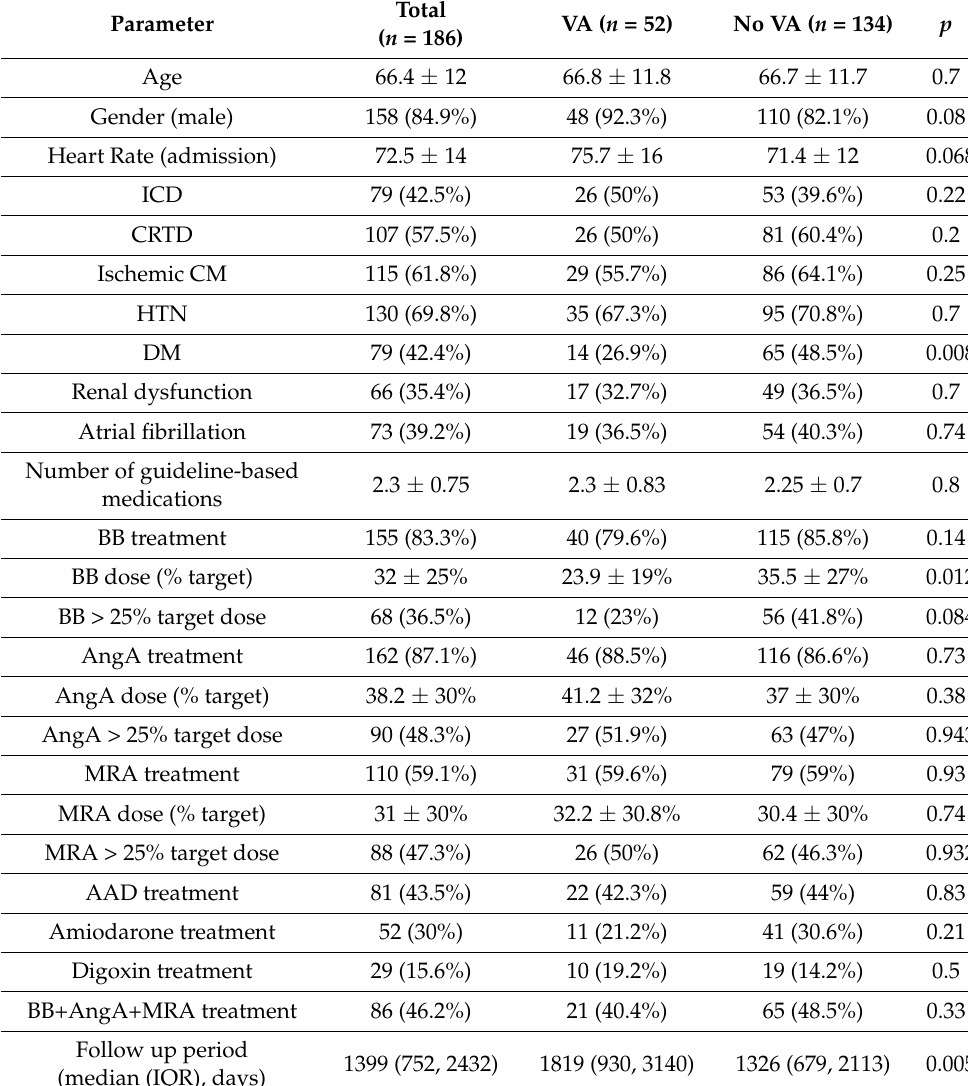
Table 1. Patient characteristics and comparison of patients with and without VA.